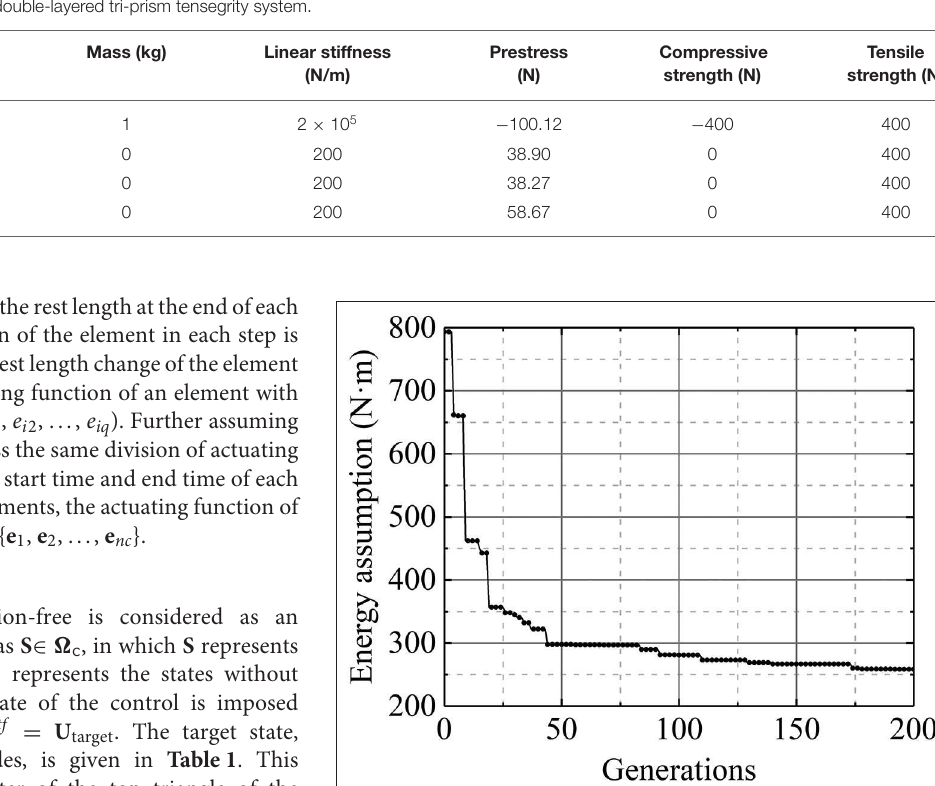
Mass (kg) Linear stiffness